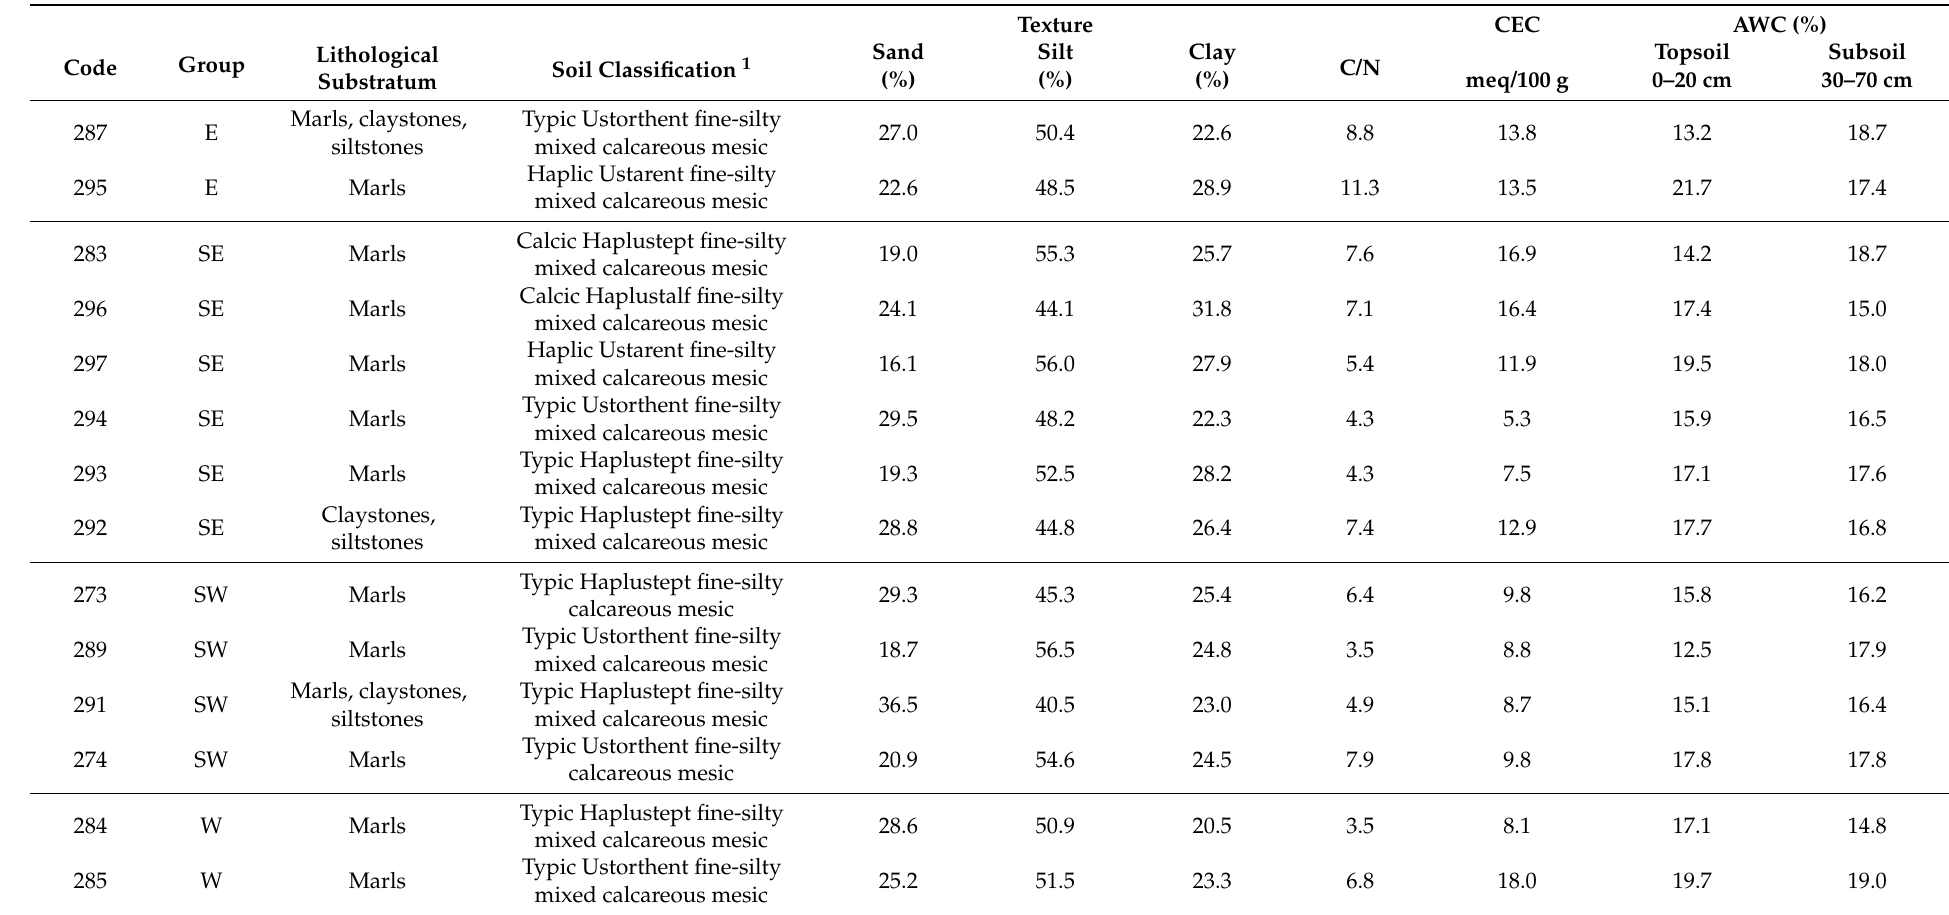
Table 2. Lithological substratum, soil classification based on USDA Soil Taxonomy, textural fraction, C/N ratio, and Cation Exchange Capacity (CEC) of the topsoil, and Available Water Capacity (AWC) of top and subsoil; average values of the main soil characteristics were calculated for each